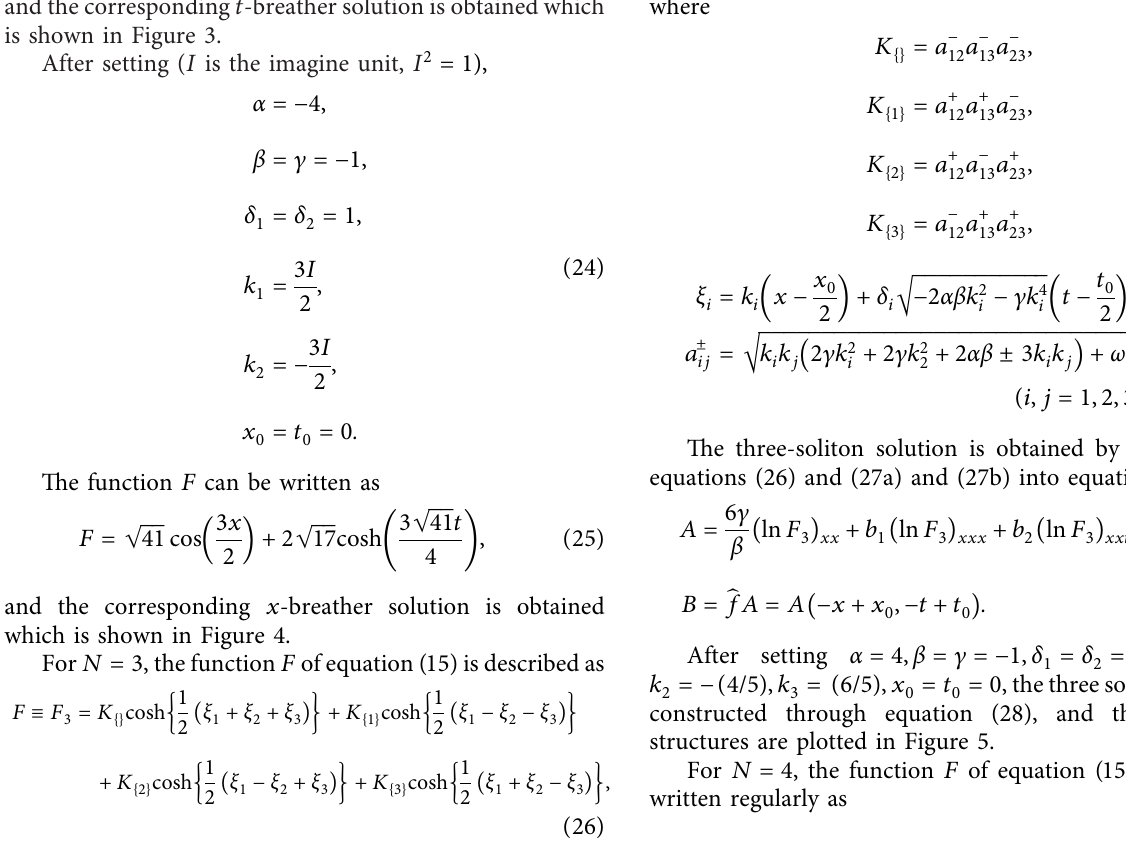
Figure 1: The single soliton solution (18) with the parameters α � 4 , β � c � − 1 , δ � b � (c) b 1 2